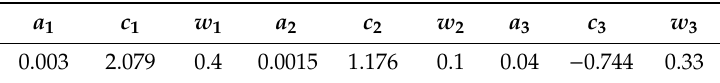
Table 1. The parameters of the PSD of the PBX 9501.